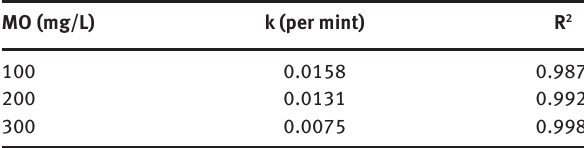
Table 3: Rate constants of Ag-Co methyl orange with various initial concentration of methyl